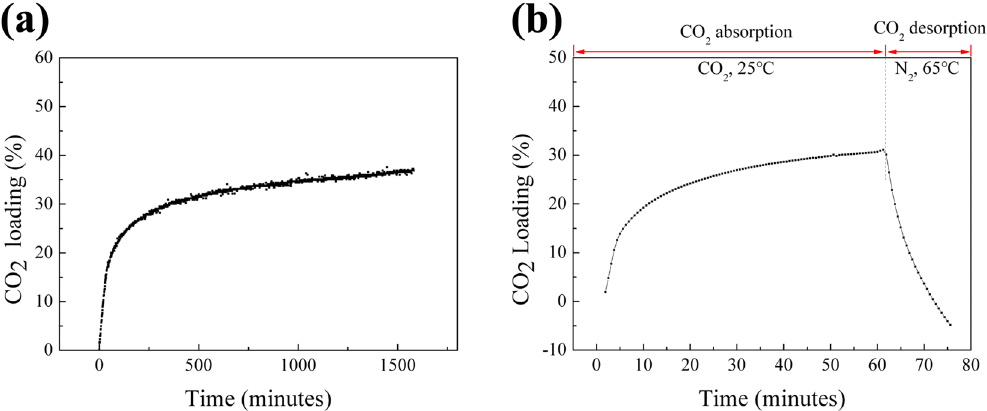
Figure 1. ( a ) CO 2 absorption kinetics of mixture of DBU and glycerol in 3:1 molar ratio at 25 °C; ( b ) CO 2 absorption and desorption on the mixture of DBU and glycerol in 3:1 molar ratio by TGA (absorption at 25 °C for 60 min; desorption by N 2 at 65 °C for 15 min).